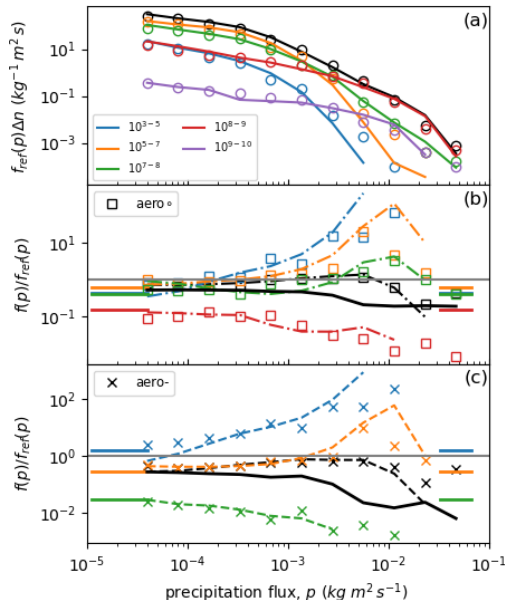
Figure 5. The double-moment reconstructions of the rainfall rate distributions in the deep convective cloud regime. (a) The simu- lated (lines) and reconstructed (circles) rainfall distributions for the high-aerosol-concentration experiment. The coloured lines show the CDNC-conditioned contributions to the total rainfall distribu- tion from the CDNC intervals in the panel’s legend. The black line is the total rainfall frequency (the sum of the coloured lines). (b, c) The simulated and reconstructed differences between the rainfall distributions in the intermediate- and low-aerosol-concentration ex- periments and the high-concentration experiment. The solid black lines show the reconstructed differences obtained if the CDNC- conditioned mean rainfall rates, λ n , are assumed to be unchanged by the aerosol perturbations. The short coloured bars indicate the changes in the normalised frequencies, for each CDNC interval, rel- ative to the high-aerosol